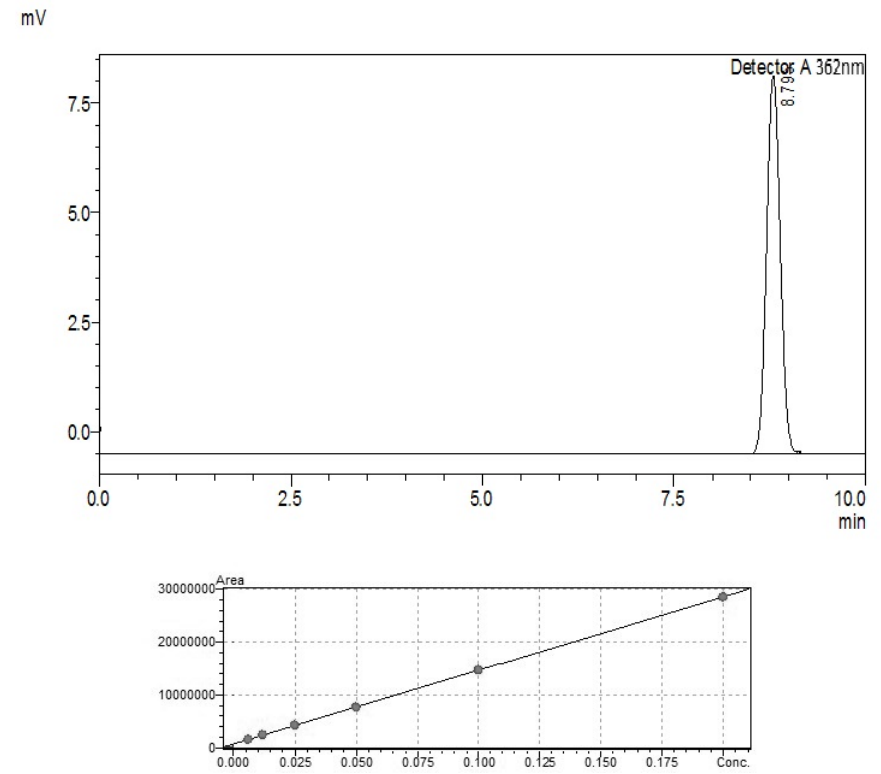
Fig. 5 Chromatogram and standard curve of quercetin (λ max – 362 nm) with a retention time of 8.79 minutes.